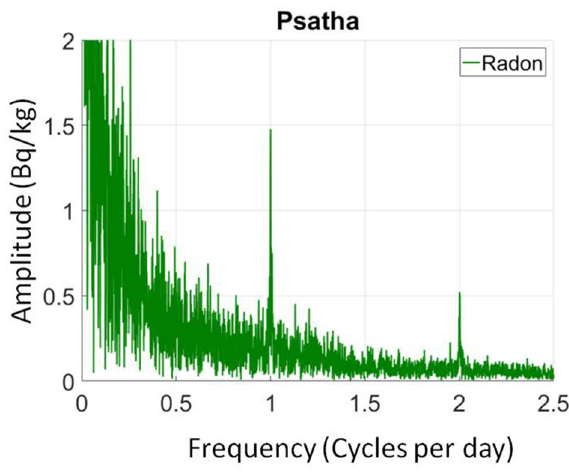
Figure 8. The strong correlation between temperature and the measured soil radon concentration is also obvious in the FFT spectrum from the prominent diurnal and semi-diurnal variation (peaks on 1 and 2 cycles per